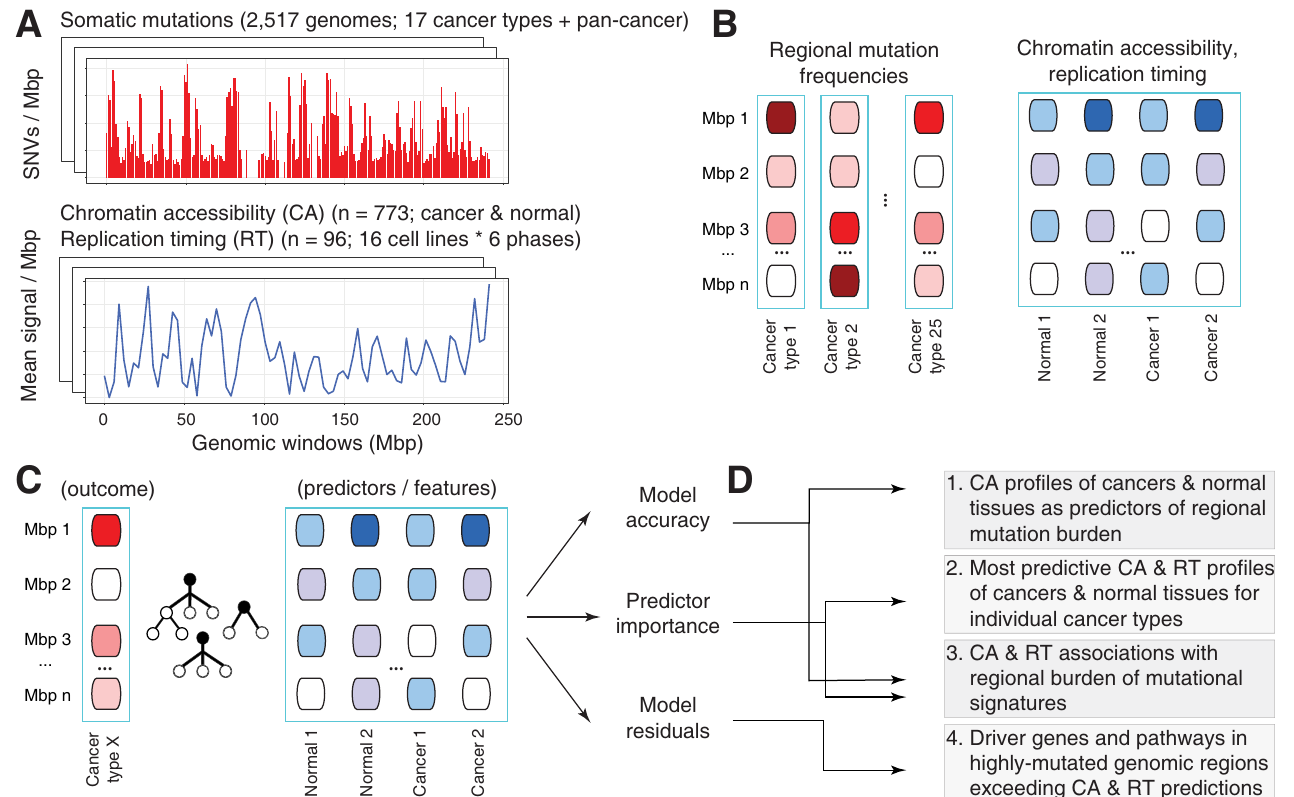
Fig 1. Characterising chromatin accessibility (CA) and replication timing (RT) as predictors of regional mutagenesis in cancer genomes. A. Somatic mutations in cancer genomes (top) and CA and RT datasets of normal tissues and cancers (bottom) were integrated to study regional mutational processes. Somatic single nucleotide variants (SNVs) of 2,517 whole cancer genomes were analysed with 869 genome-wide epigenetic profiles, including 773 CA profiles of primary human cancers, normal tissues, and cell lines from ATAC-seq experiments, and 96 RT profiles of 16 cell lines and six cell cycle phases from RepliSeq experiments. B. Genomic regions of one megabase (Mbp) were analysed. Regional mutation burden was estimated as the number of SNVs per megabase region. The mean values per region were derived for CA and RT profiles. C. Random forest models were trained using regional mutation burden profiles as the outcome and CA and RT profiles as the predictors. We analysed the pan-cancer dataset and 17 datasets of specific cancer types for which relevant CA and RT profiles were available. D. To associate regional mutation burden with CA and RT, mutational signatures, and cancer driver genes, the random forest models were evaluated in terms of accuracy, predictor importance, and model